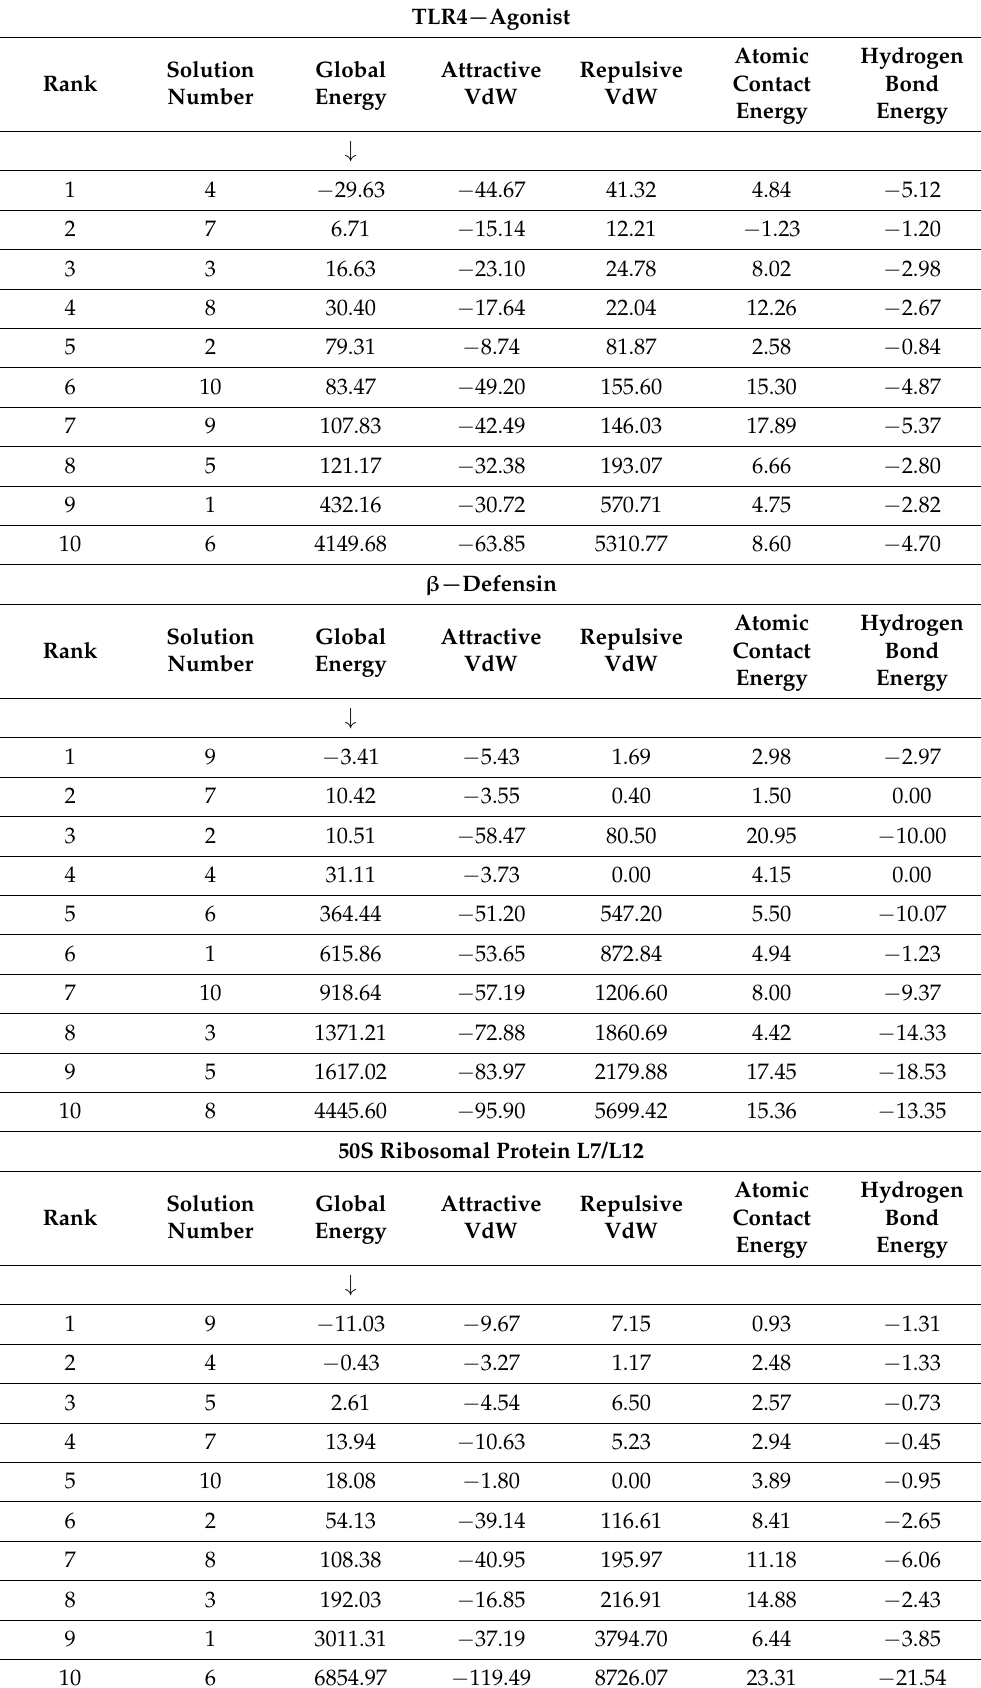
Table 3. Top 10 docked complexes of designed vaccines with TLR4. The values can be interpreted in